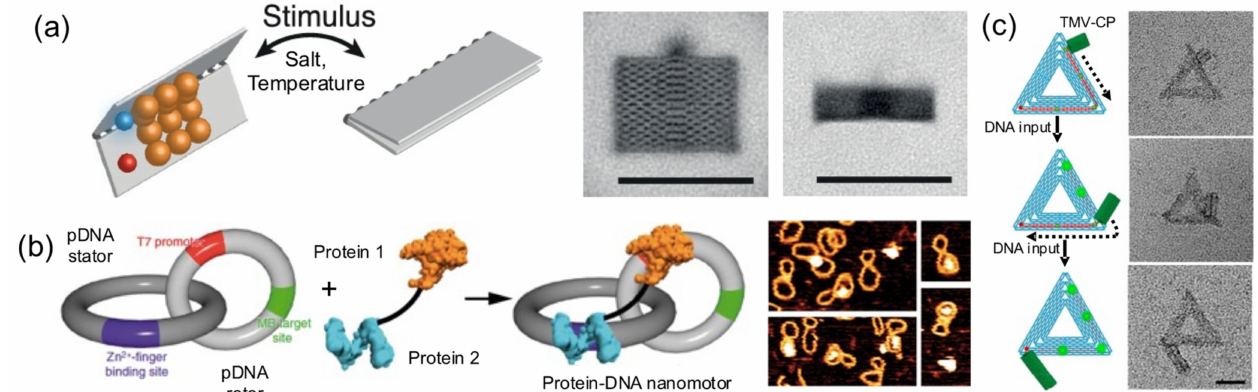
Figure 9. Dynamic hybrid nanostructures. ( a ) ELP opens and closes a hinge-type DNA origami upon a stimulus. TEM images (left). Scale bars: 100 nm. Adapted from [24]. ( b ) Two intertwined dsDNA rings harbored a dimerize Zinc finger and an RNA polymerase, causing the latter to rotate the ring with a T7 promotor. AFM images (right). Reprinted from [37], with permission from Springer Nature, 2018. ( c ) Dynamic assembly of Tobacco Mosaic Virus coat proteins (TMV-CP) on a DNA Origami controlled by DNA oligonucleotide toehold-mediated strand exchange. Scale bar: 50 nm. Adapted from [35], with permission from American Chemical Society,